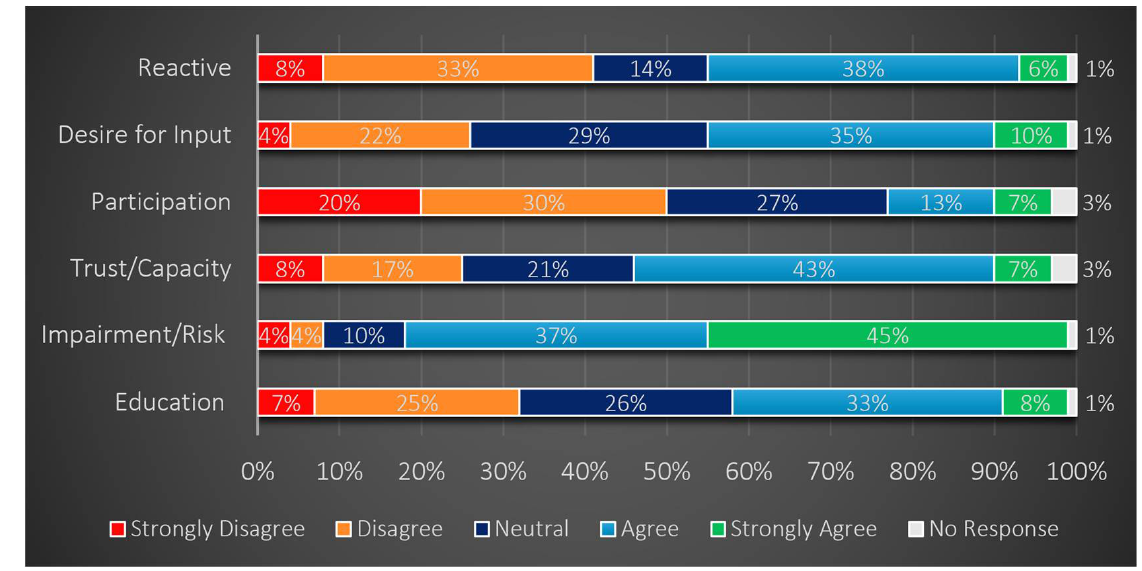
Figure 6. Citizen self-assessments of watershed governance behaviors ( n = 168).